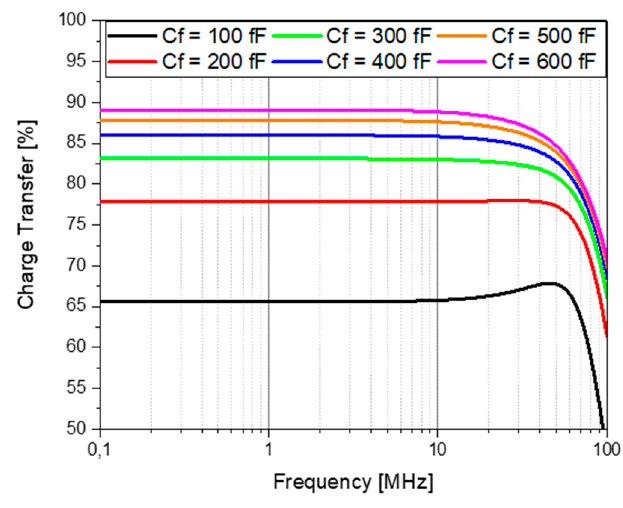
Figure 6. Charge transfer obtained for different feedback capacitances ( C f ).